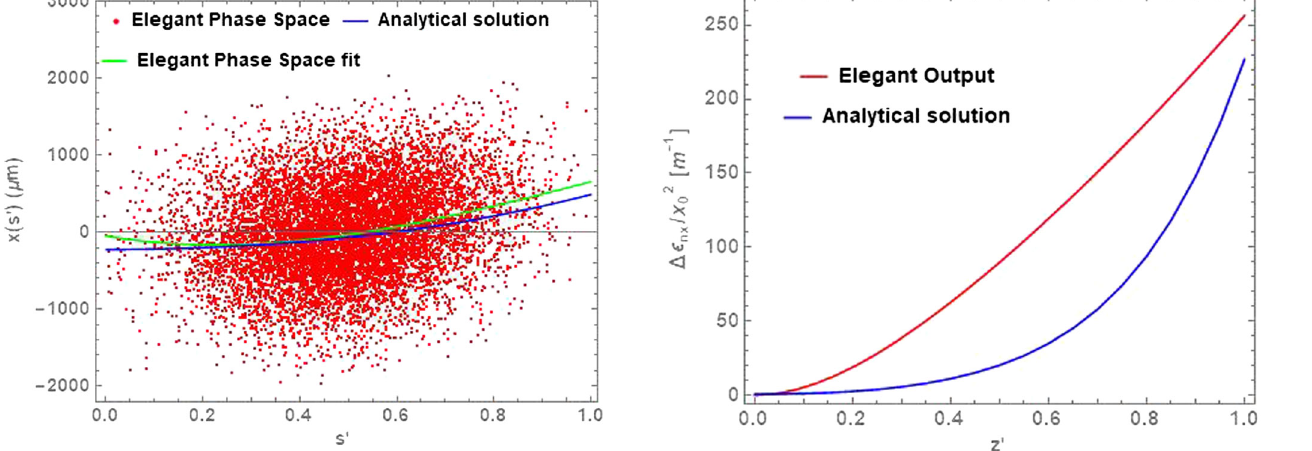
FIG. 45. Comparison of x ð z 0 ¼ 1 ; s 0 Þ between the ELEGANT tracking code results and the analytical formulation for a bunch which has traveled through the 24 rf structures of XARA. Shown in red is the raw phase space of the bunch, a fit of which is given in solid green. The analytical result is shown in blue.